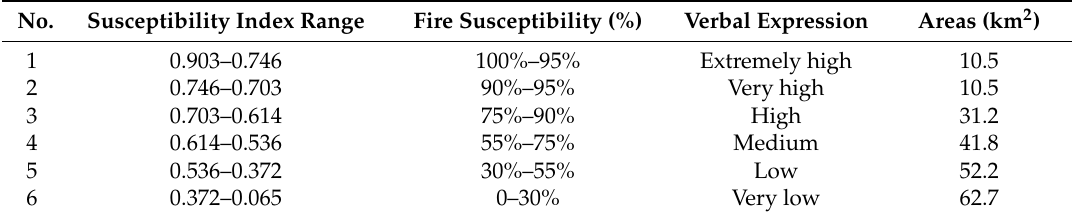
Table 3. Forest fire susceptibility classification derived from the Kernel logistic regression